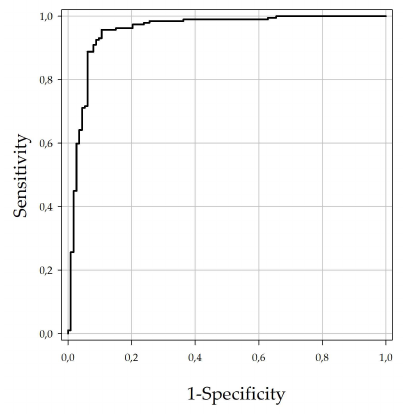
Figure 1. ROC analysis employing 300 Nigerian cattle sera: Diagnostic sensitivity of the DUGV ELISA is 95.7% (95% CI 91.7–98.1) and diagnostic specificity is 88.6% (95% CI 81.3–93.8) with AUC being 0.951 ( p -value < 0.001).